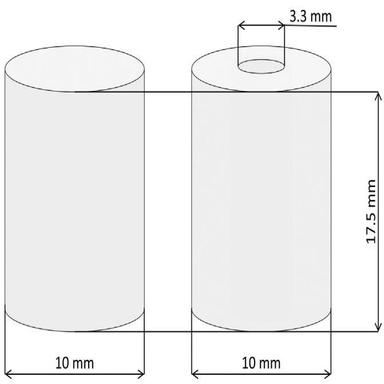
Geometry after compaction in the present compaction experiments. Height 17.5 mm and diameter 10 mm. Left geometry used for reverse engineering and right geometry, with an inner hole of 3.3 mm, used for verification.